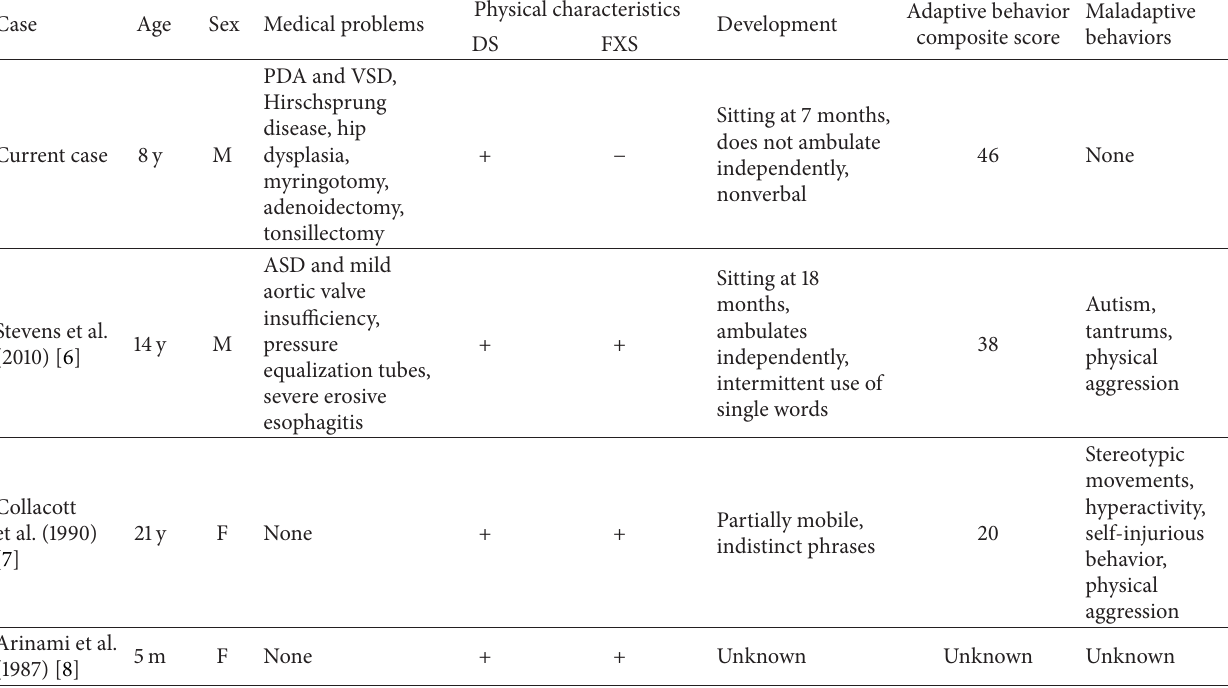
Table 1: Cooccurrence of Down syndrome and Fragile X syndrome